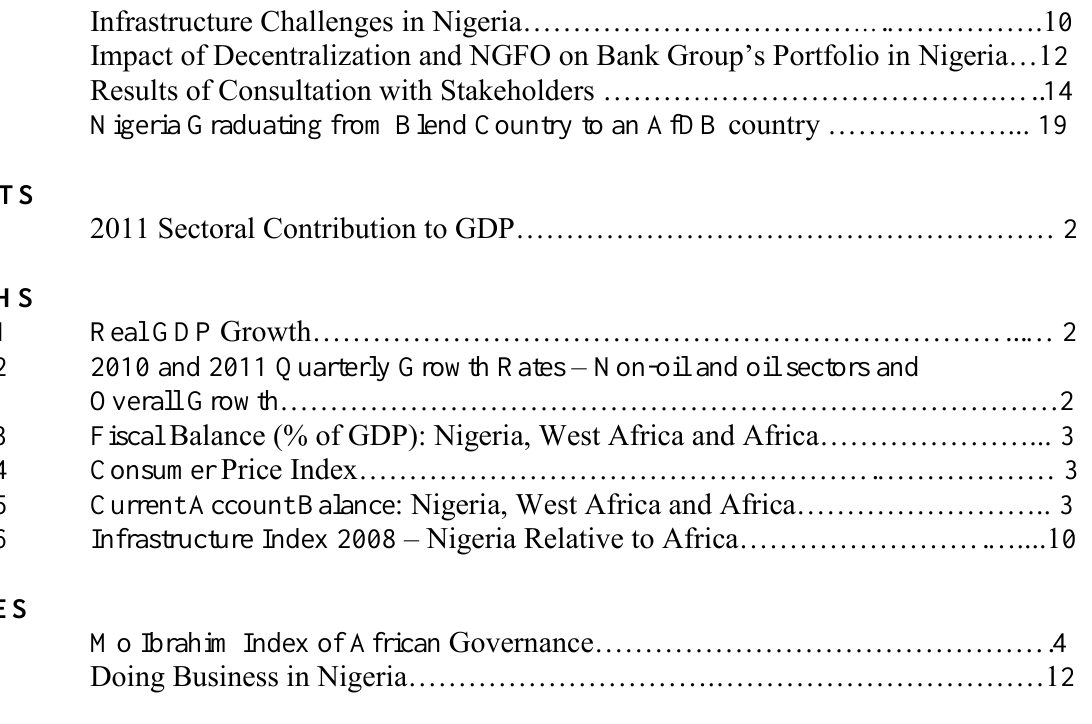
TABLES Table 1 Table